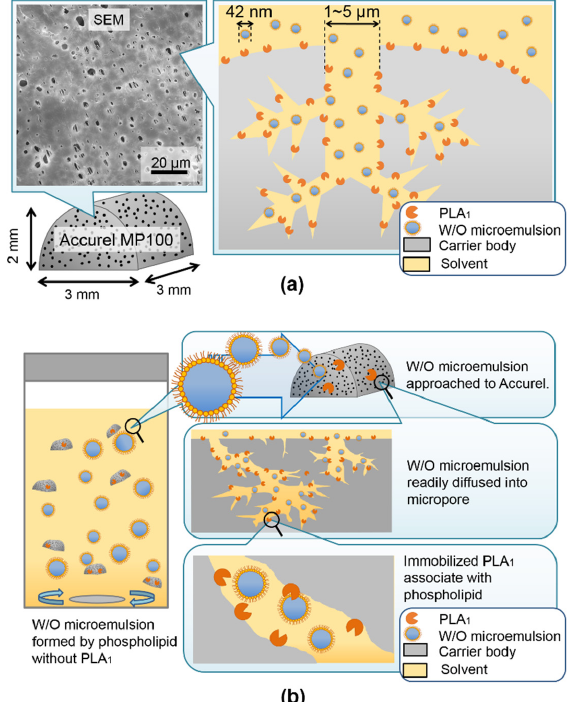
Figure 4. ( a ) Schematic illustration of pore structure and W/O microemulsion droplets association with immobilized phospholipase A 1 on the outer and inner surfaces of microspores in Accurel particles. ( b ) Phospholipid-based W/O microemulsion droplets readily diffused into the microspores of the PLA 1 carrier.